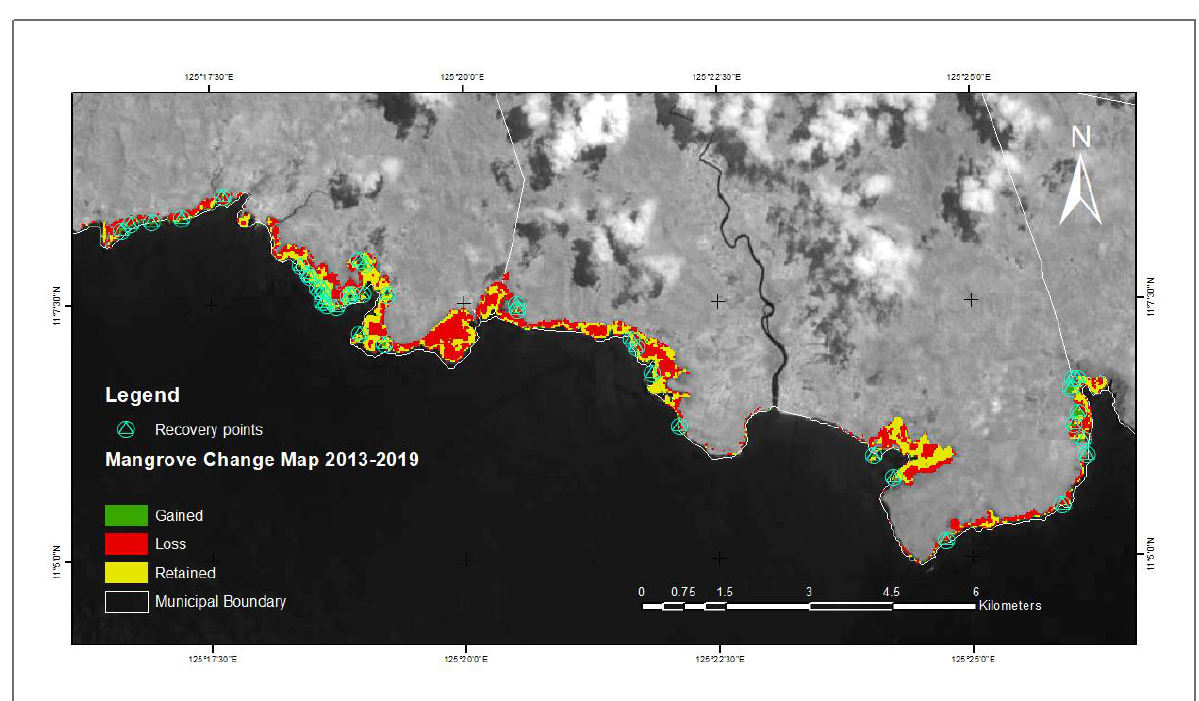
Figure 1: Mangrove recovery points across the study area from mangrove change map (2013-2019) (modified from Cabello et. al. 2021)